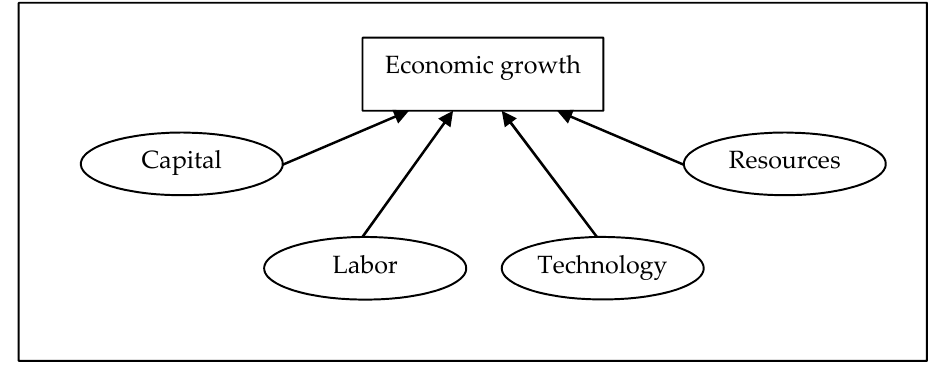
Figure 1. Factors of economic growth.